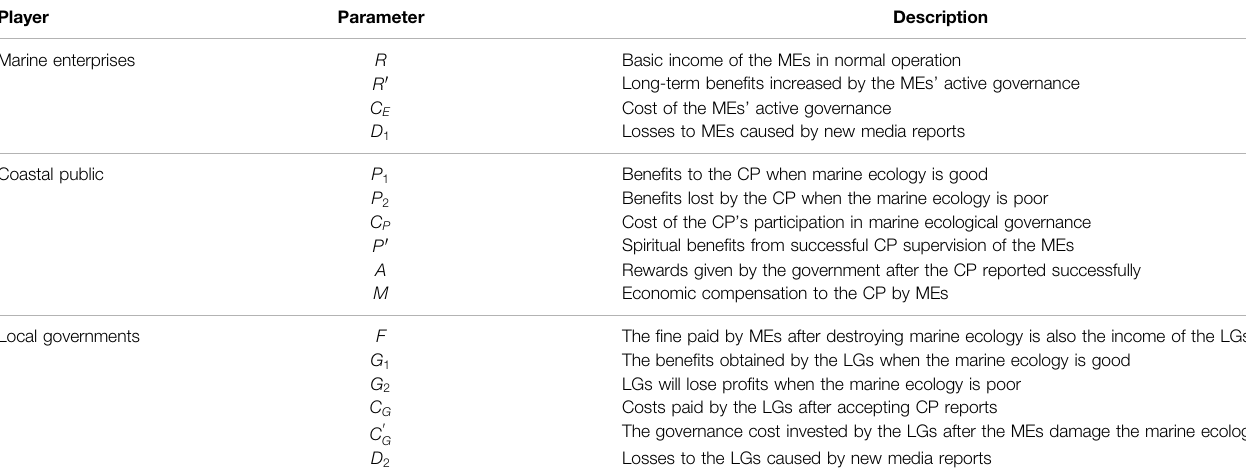
TABLE 1 | Model parameters and de fi